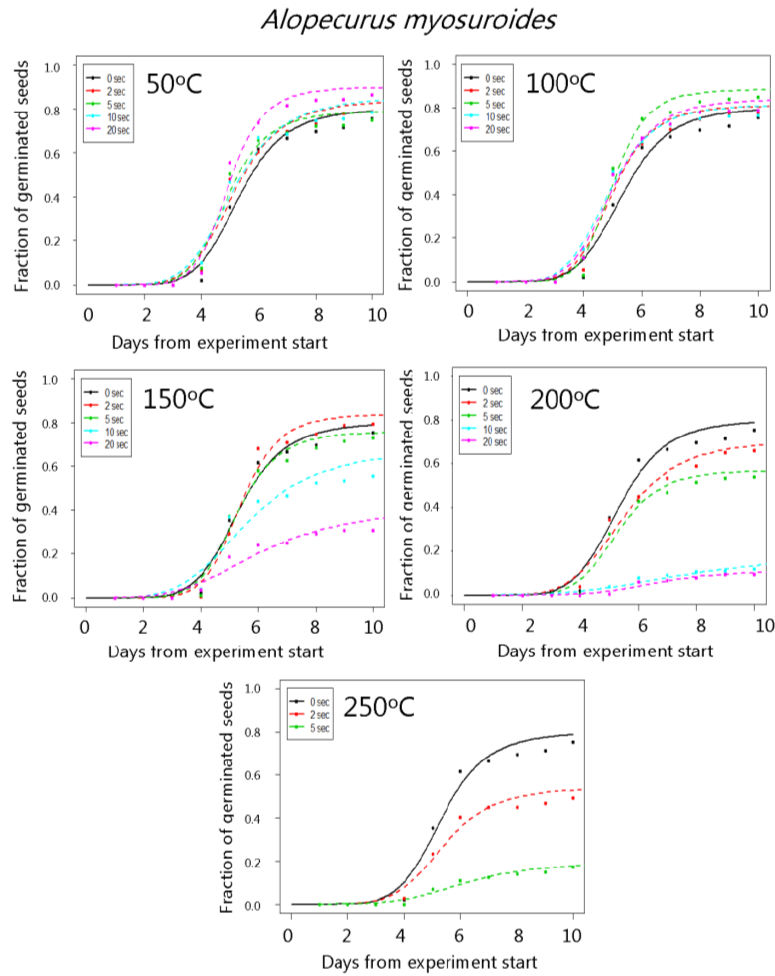
Figure 2. Germination curves of seed lots of the grass weed Alopecurus myosuroides treated with various temperature and